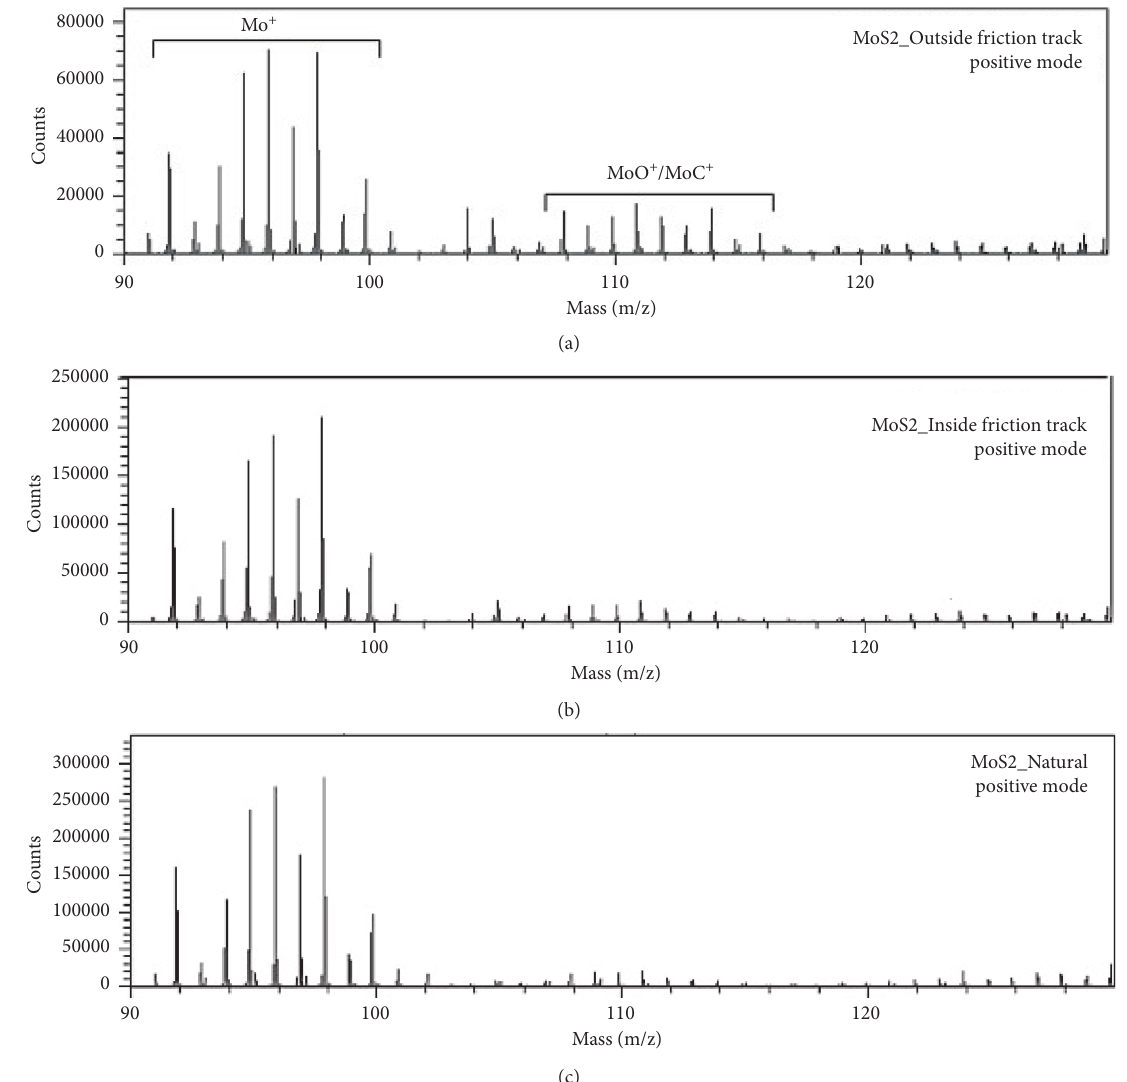
Figure 11: Natural, inside friction, and outside friction track TOF-SIMS spectra of MoS